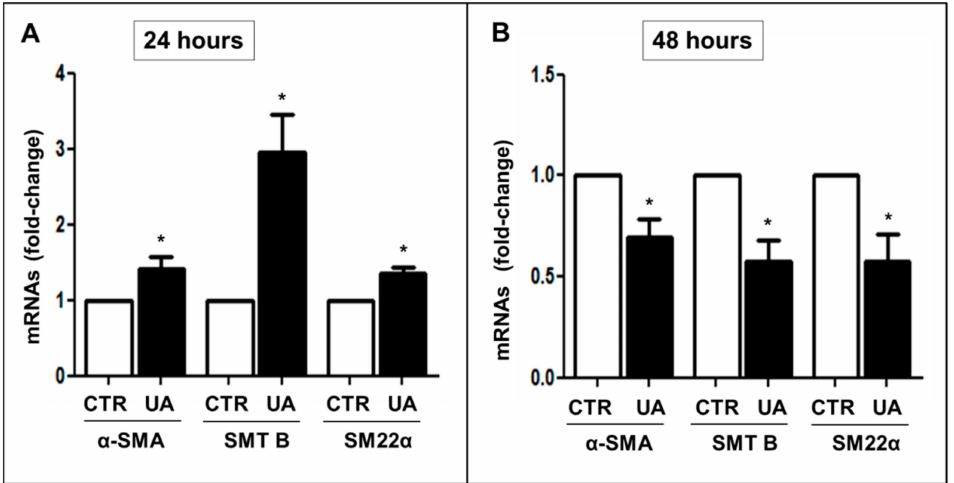
Figure 2. UA effect on cytoskeleton components of MOVAS cells. ( A ) 24 h 9 mg/dL UA exposition increased α -SMA, SMT B and SM22 α mRNAs, ( B ) whereas at 48 h they were down regulated. mRNAs were evaluated by rt-PCR. All results represent means ± SEM obtained from four/five independent experiments and are expressed as fold change to CTR. * p < 0.05 vs. CTR. UA = Uric Acid; α - SMA = α -Smooth Muscle Actin; SMT B = Smoothelin B; SM22 α = Smooth Muscle 22 α ; rt-PCR = real time PCR; CTR = Control, untreated